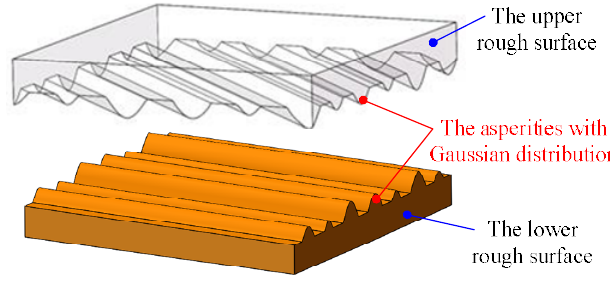
Figure 5. The schematic diagram of the contact model.